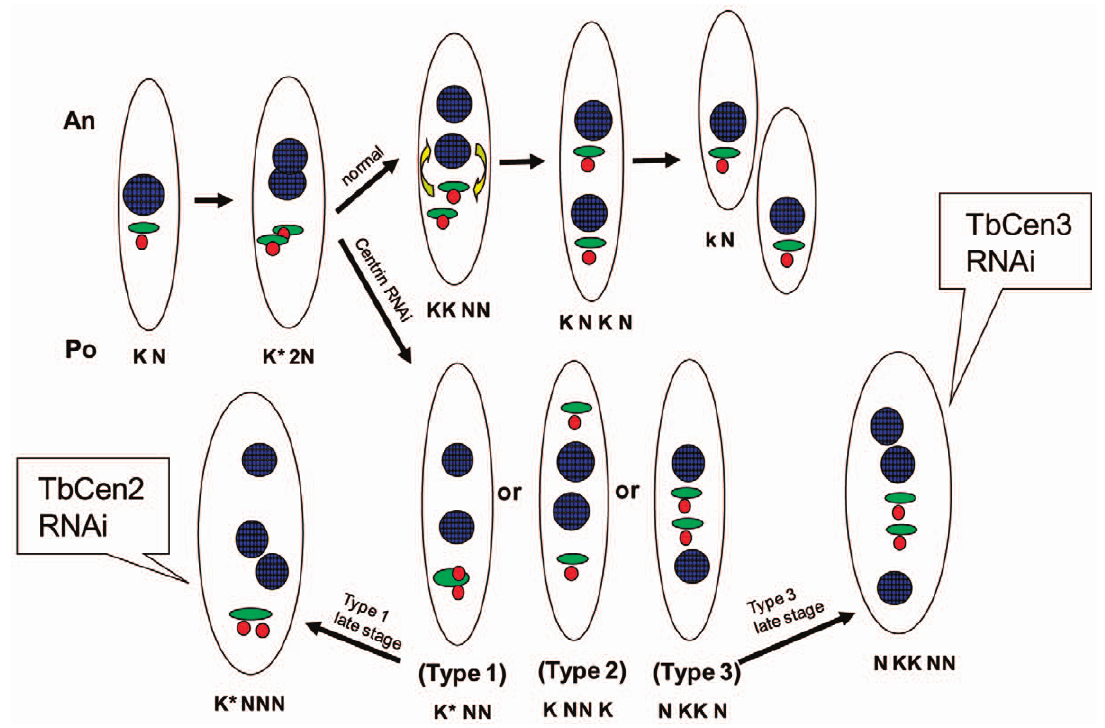
Figure 6. Schematic diagram of the organelle segregation and the failure of segregation in the absence of TbCen2 or 3 in T.brucei procyclic form. Normal cell division and the three different types of abnormal segregation patterns of the organelles during centrin RNAi leading to the failure in cytokinesis and the generation of giant cells with multiple organelles are shown. Color coordination for organelles colored: red, basal body; green, kinetoplast; blue, nucleus.